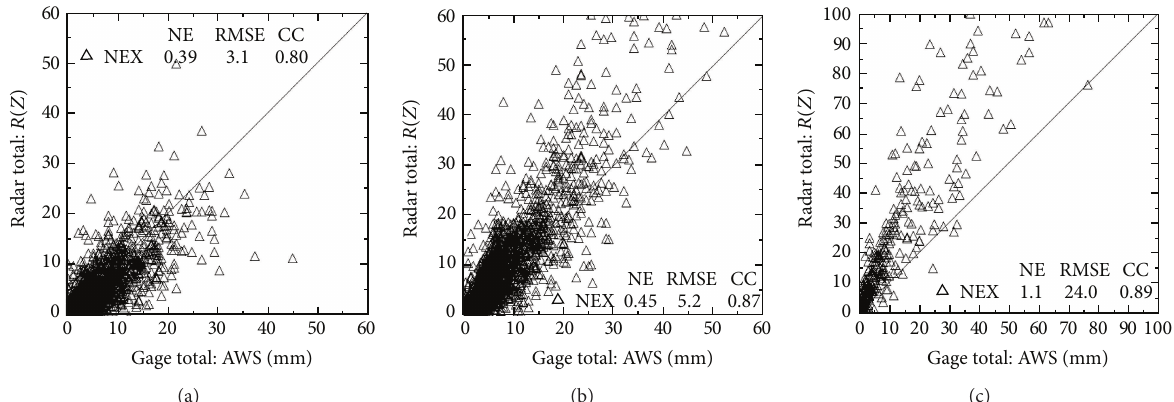
Figure 8: Scatterplots of gage rainfall against radar rainfall obtained using the tropical 𝑅(𝑍) relation derived from the US NEXRAD network for (a) Case 1, (b) Case 2, and (c) Case 3.